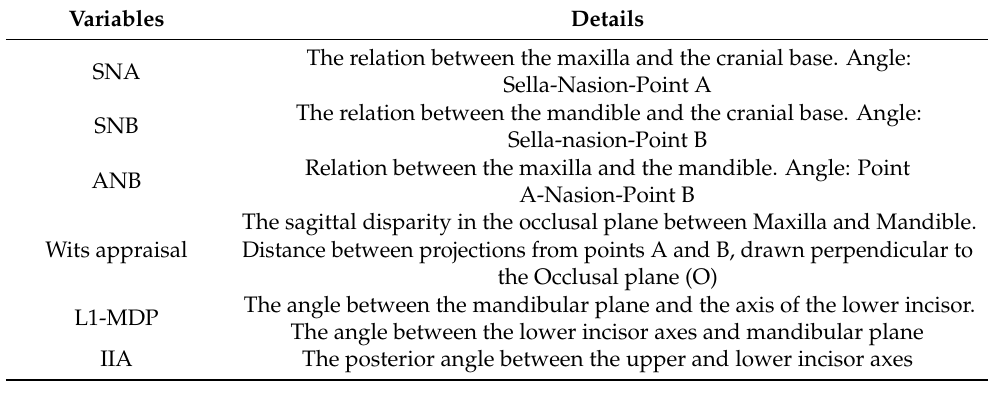
Table 4. List of parameters used in the meta-analysis.